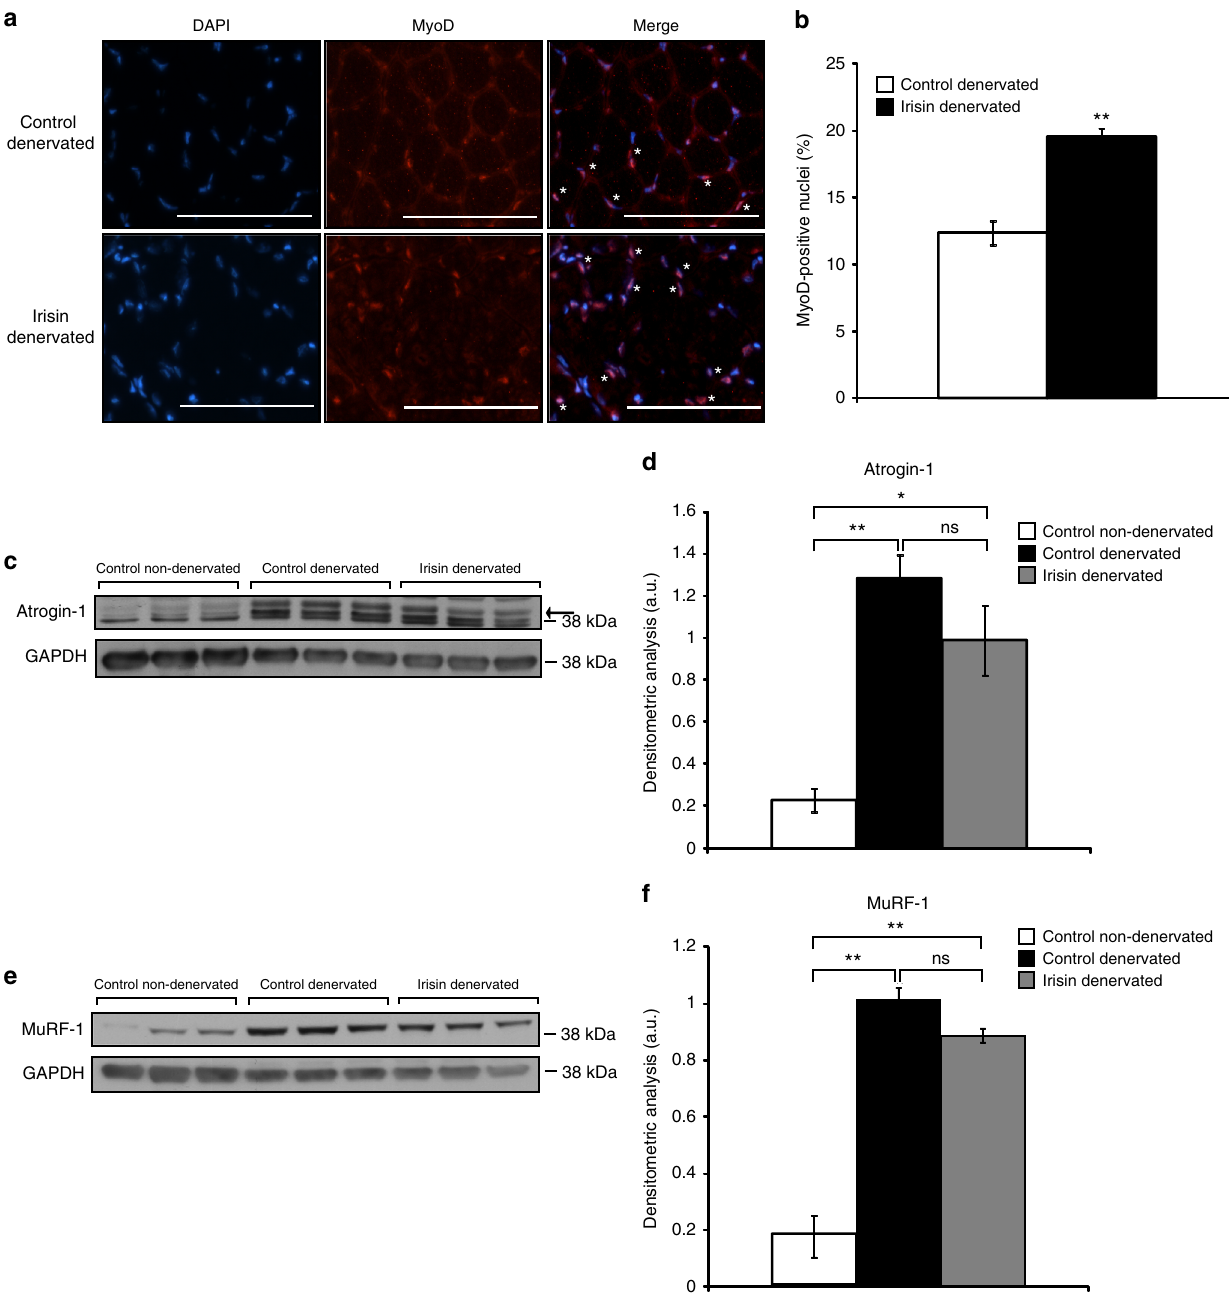
Fig. 9 Irisin treatment rescues denervation-induced muscle atrophy. a Representative images of MyoD immunostaining of TA muscle sections from denervated mice injected with either DB (control) or irisin. Images were captured using a ×20 objective. Scale bar represents 100 μ m. Nuclei were counterstained with DAPI. White asterisks denote MyoD-positive cells. Linear brightness and contrast of ‘ Merge ’ panel was adjusted to visualize MyoD + nuclei without altering the interpretation of results in any way. b Graph displaying the percentage of MyoD-positive cells in TA muscle sections from denervated mice injected with either DB (control) or irisin pre and post sciatic nerve transection. c IB analysis of Atrogin-1 protein levels in Gas muscle from non-denervated mice injected with DB (control) and denervated mice injected with either DB (control) or irisin. The levels of GAPDH were assessed as a loading control. Arrow indicates Atrogin-1 band. d Graph shows densitometric analysis of Atrogin-1 levels in arbitrary units (a.u), normalized to GAPDH. e IB analysis of MuRF-1 protein levels in Gas muscle from non-denervated mice injected with DB (control) or denervated mice injected with either DB (control) or irisin. The levels of GAPDH were assessed as a loading control. f Graph shows densitometric analysis of MuRF-1 levels in a.u, normalized to GAPDH ( n = 3 biological replicates). Error bars represent mean ± SEM. Student ’ s t -test was performed for b and one-way ANOVA was performed for d and f . Signi fi cance is indicated with * p < 0.05 and ** p <